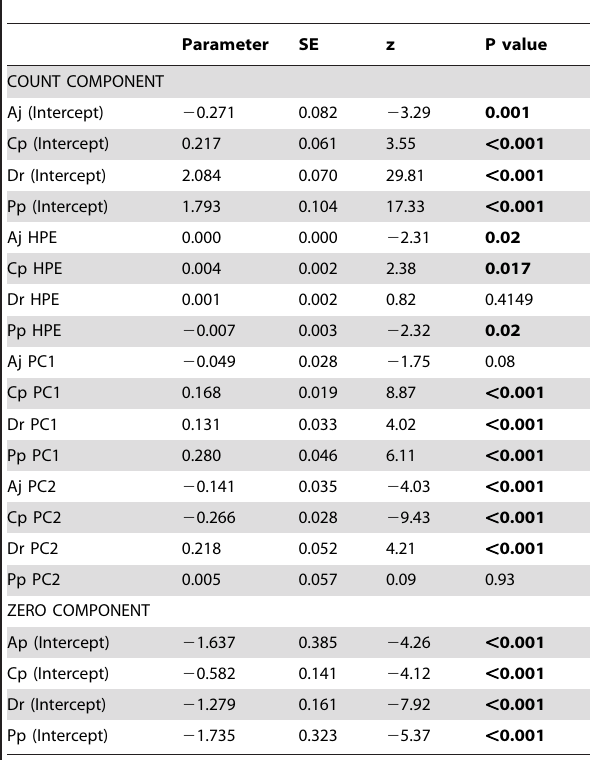
Table 2. Parameter values for the best model (model 1 in Table 1) describing the effects of disturbance and climate on fly abundance per bat host